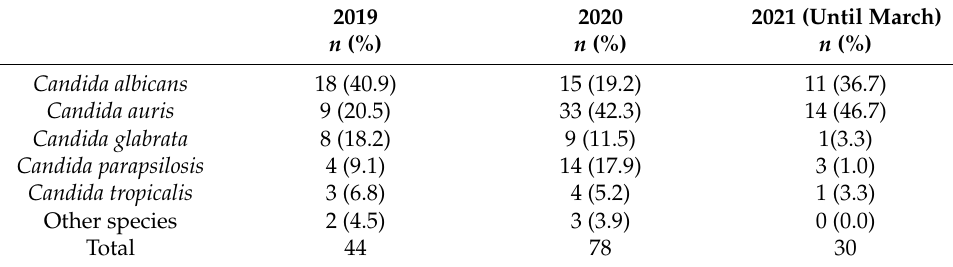
Figure 1. Temporal evolution of candidaemia cases (left axis) and SARS-CoV-2 cases (right axis). Table 1. Etiology of candidaemia cases by